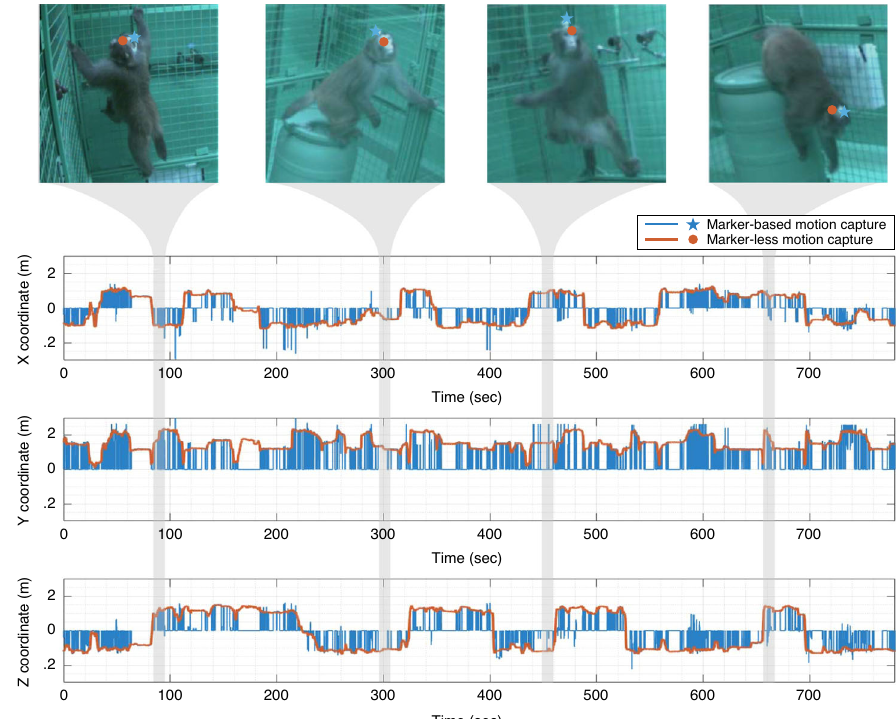
Fig. 3 Pose tracking validation. The head location reconstructed by OpenMonkeyStudio is compared with a marker-based motion capture system (OptiTrack) over time. The marker-based system produces noisy measurements due to the marker confusion, which requires an additional manual re fi nement. The median error is 6.76 cm. The images overlaid with the projection of the 3D reconstruction show visual